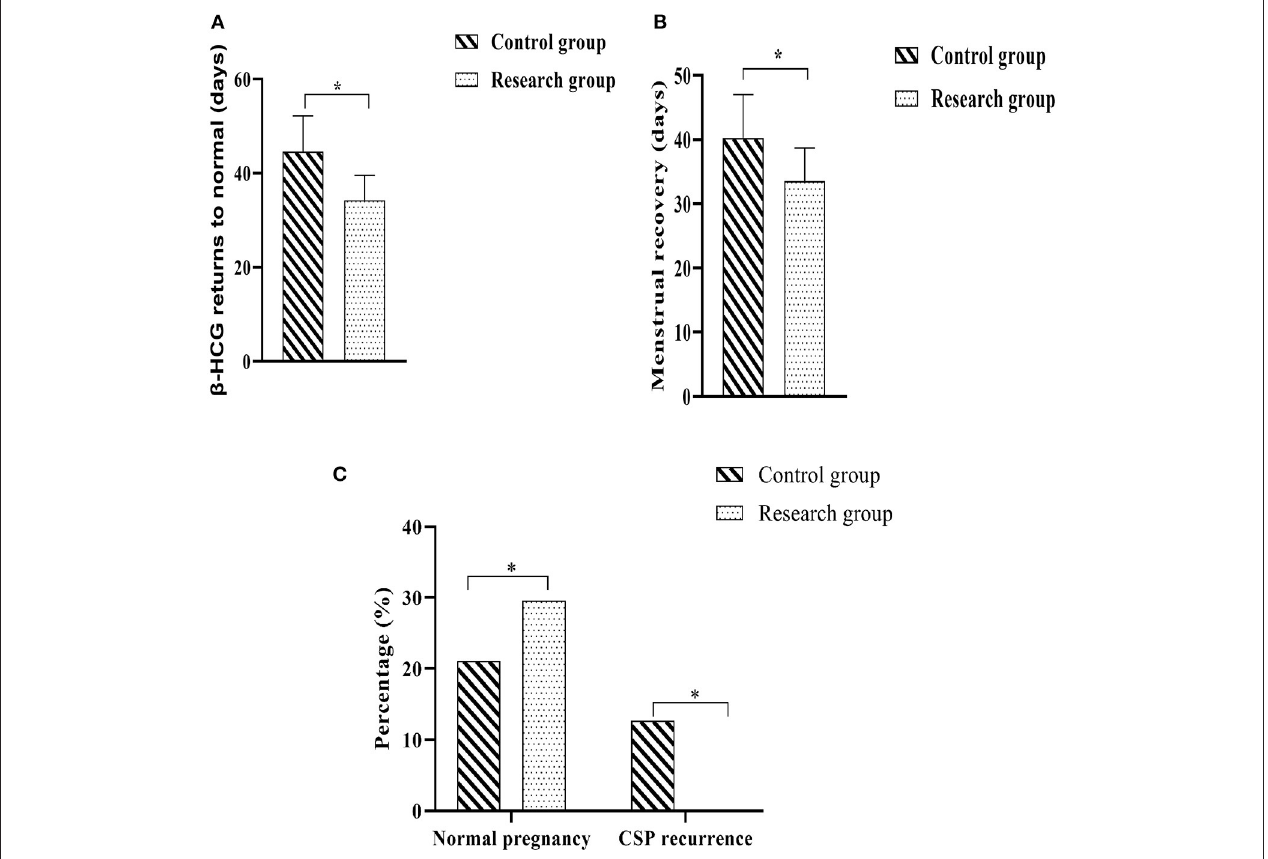
FIGURE 4 | Comparison of the improvement of clinical symptoms and pregnancy outcome between the two groups. (A) Time to normalization of β -HCG; (B) Time to return to normal menstruation; (C) Normal pregnancy rate and CSP recurrence rate. Comparison between the two groups, * P < 0.05.